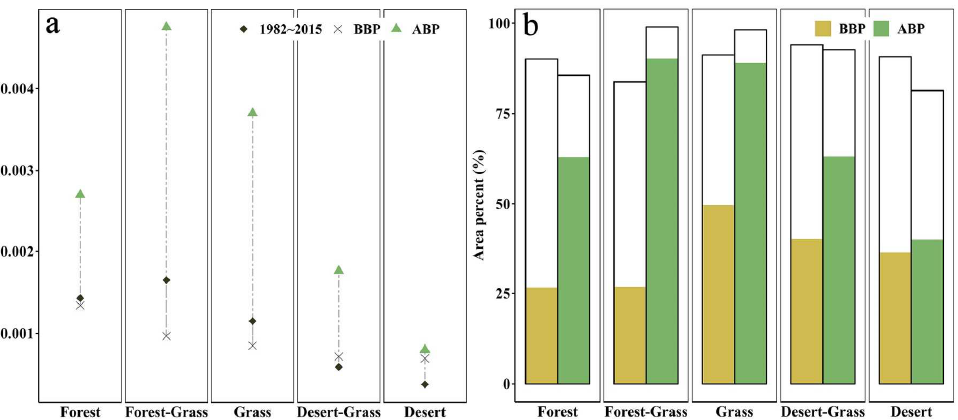
Figure 5. Trends of NDVI variation in five bioclimatic zones over different periods. ( a ) Average changing rate; ( b ) Percentage of the greening area with significant ( p < 0.05) variations of NDVI.